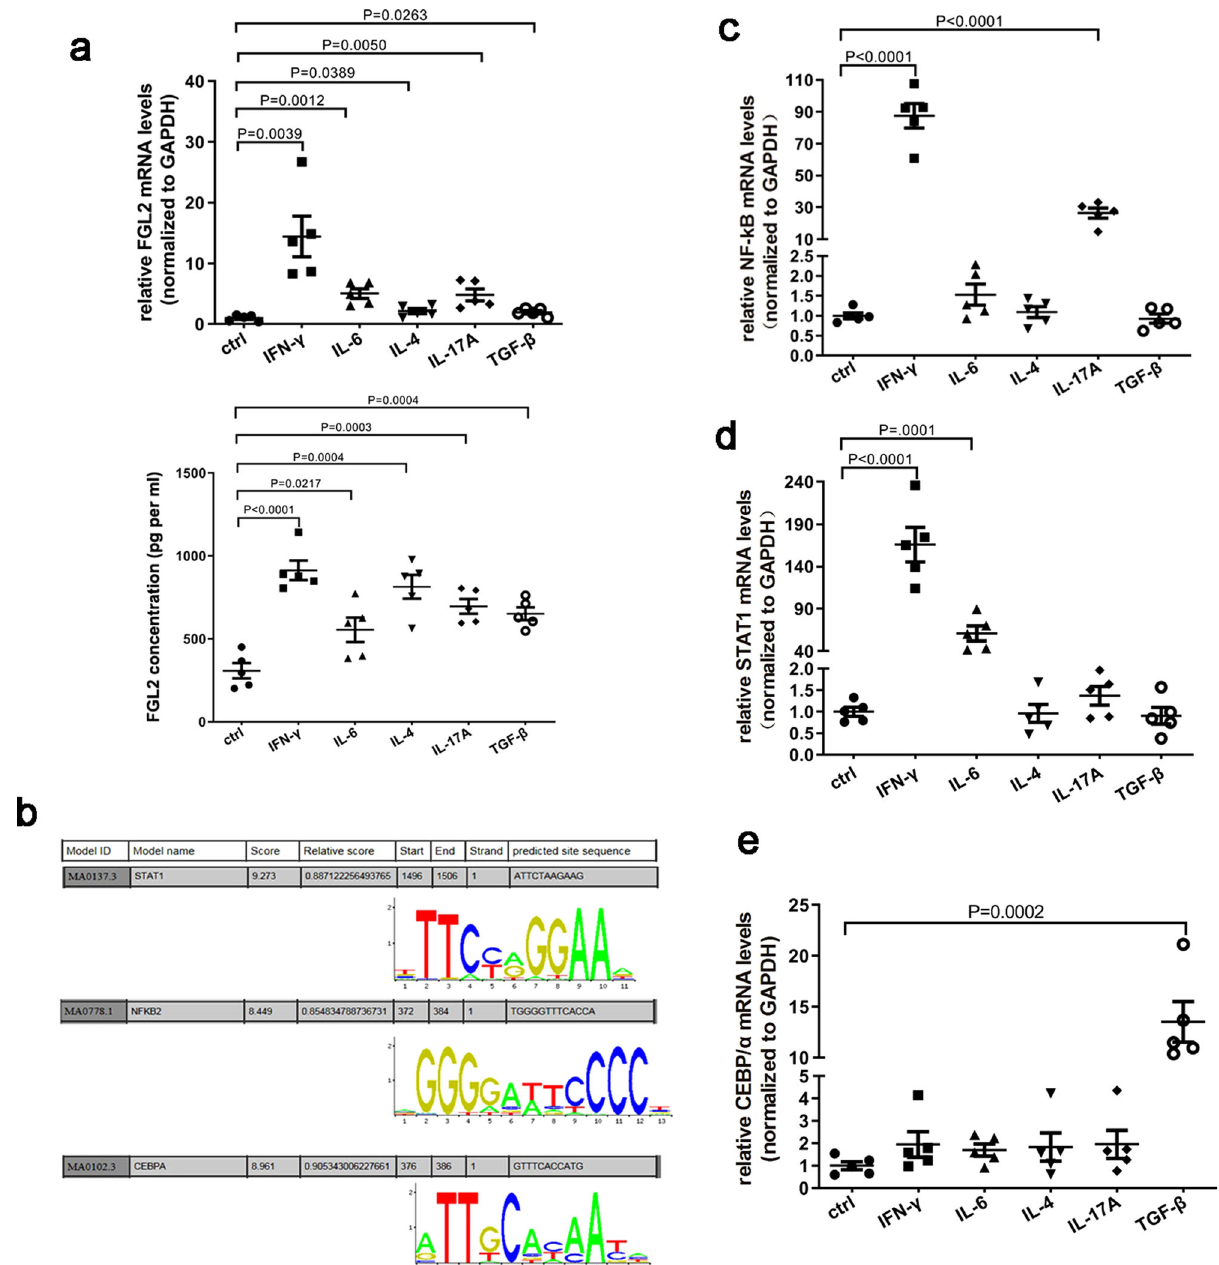
Fig. 3 Cytokines induced FGL2 expression via different pathways in Tregs. a Tregs were isolated and stimulated with indicated cytokines. FGL2 mRNA was examined by qRT-PCR after 24 h, the concentration of FGL2 in the supernatant was detected by ELISA. b Predicted binding sites of transcription factors STAT1, NF- κ B, and C/EBP α on the FGL2 promoter region. c – e Differentially expressed NF- κ B ( c ), STAT1 ( d ), and C/EBP α ( e ) genes in Tregs treated with indicated cytokines. Data represent the mean value ± SEM of fi ve individual experiments ( n =